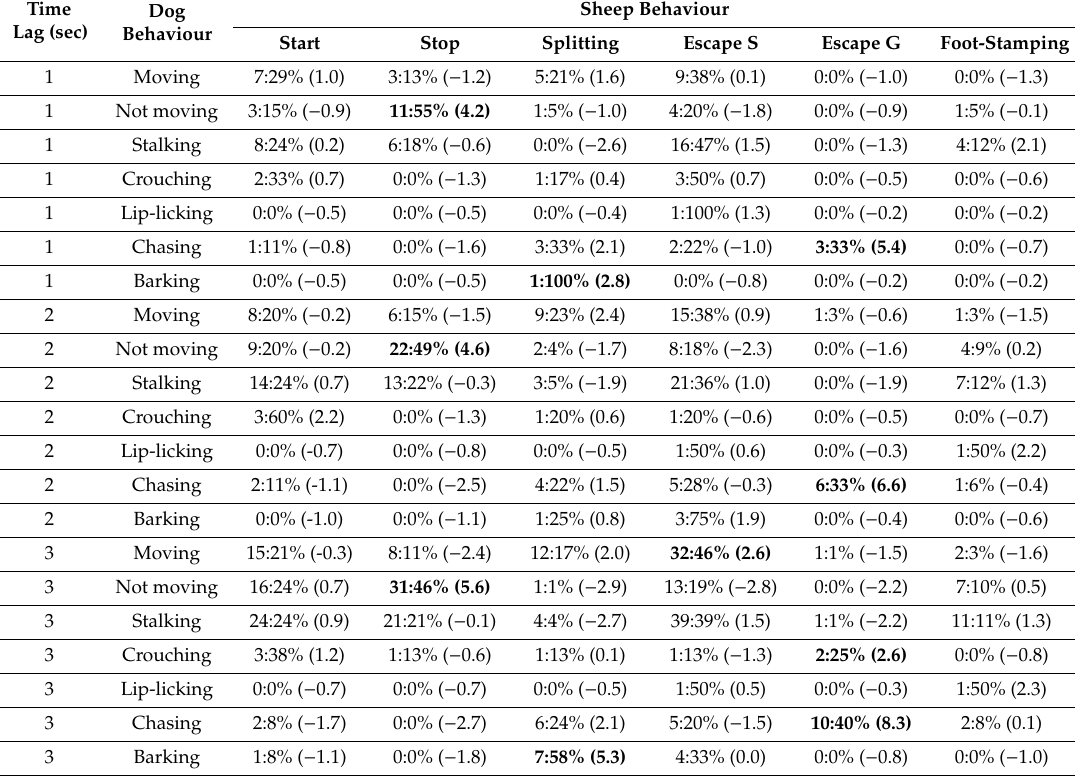
Table A4. Summary of observed frequencies, conditional probabilities, and adjusted residuals of sheep behaviour in response to dog behaviour across the three time-based lags (one, two and three seconds).